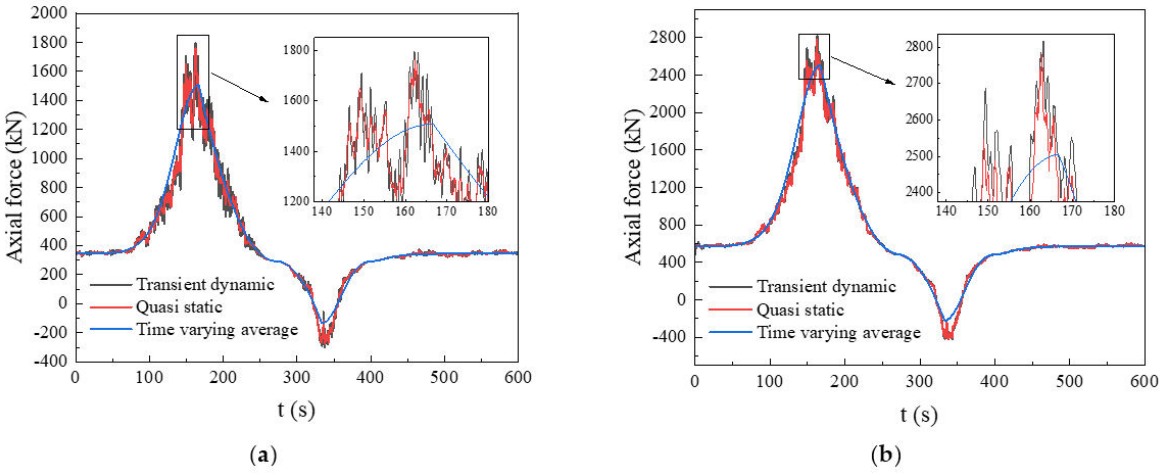
Figure 10. Time history of tower leg axial force response: ( a ) single tower; ( b ) tower-line system.